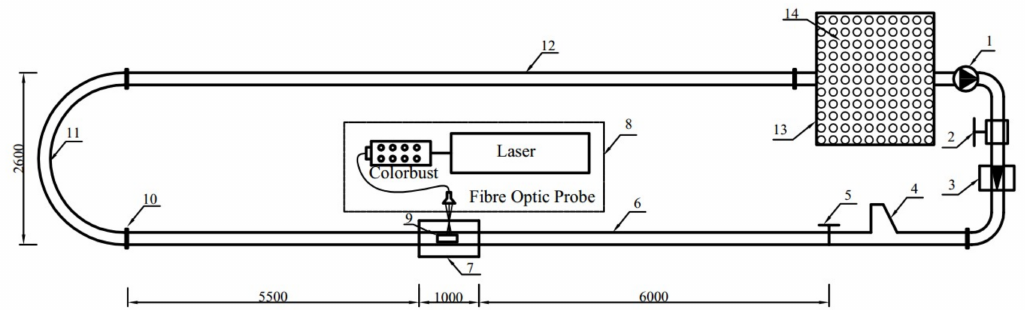
Figure 4. Layout sketch of experiment facilities. Note: 1—Centrifugal pump; 2—Gate